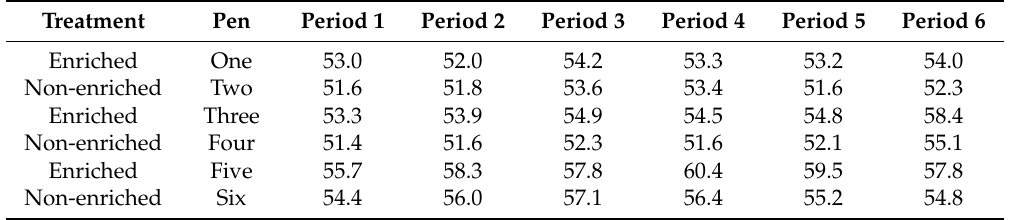
Table 4. Median percentage of time together inside and outside for all possible pairs of hens during successive 10-day periods.